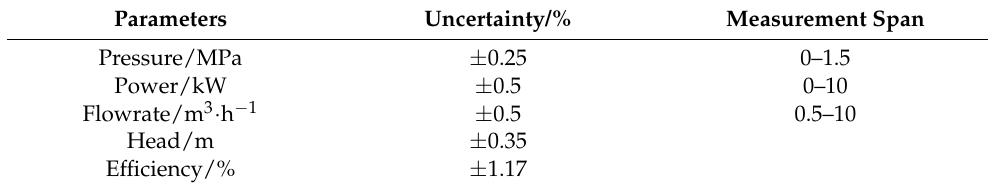
Table 2. Experimental uncertainty.